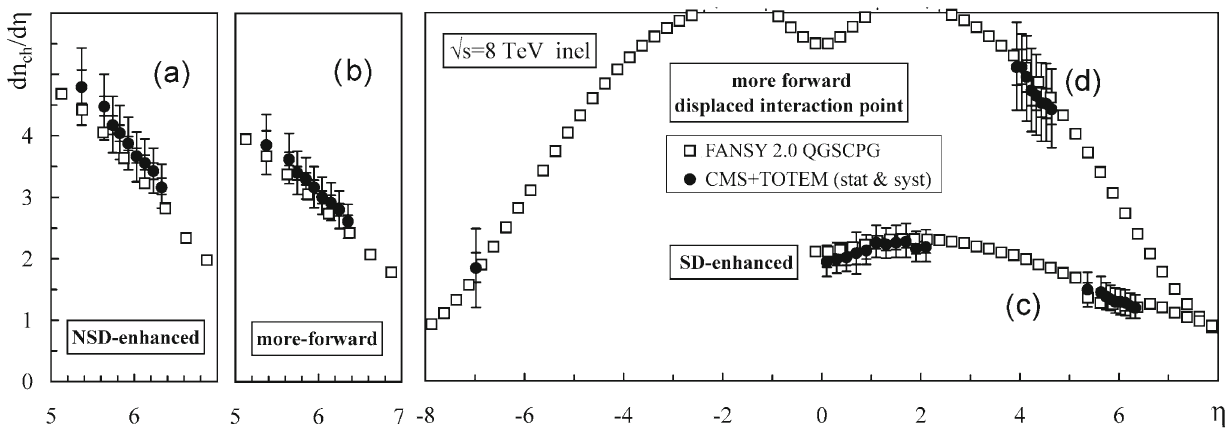
Fig. 5 CMS+TOTEM [41] and FANSY 2.0 QGSCPG’s dn ch / d η data √ s = 8 TeV under the following for events selected at